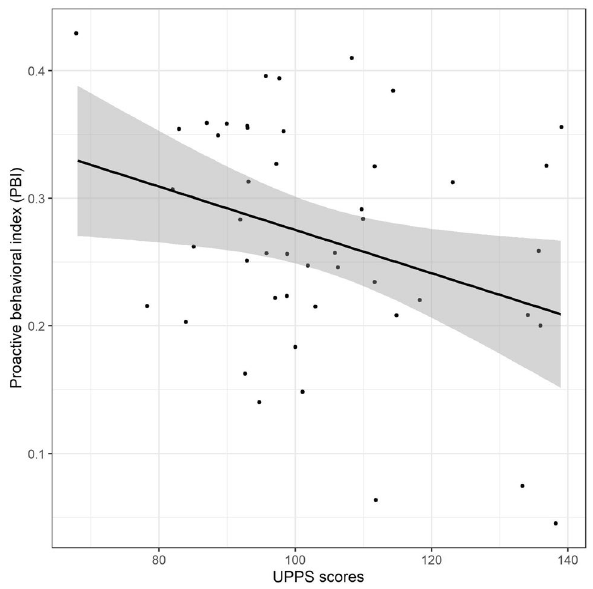
Figure 2. Correlation between the impulsiveness scores, assessed through the UPPS scores, and the global PBI calculated across all blocks. The grey area represents the 0.95 confidence interval